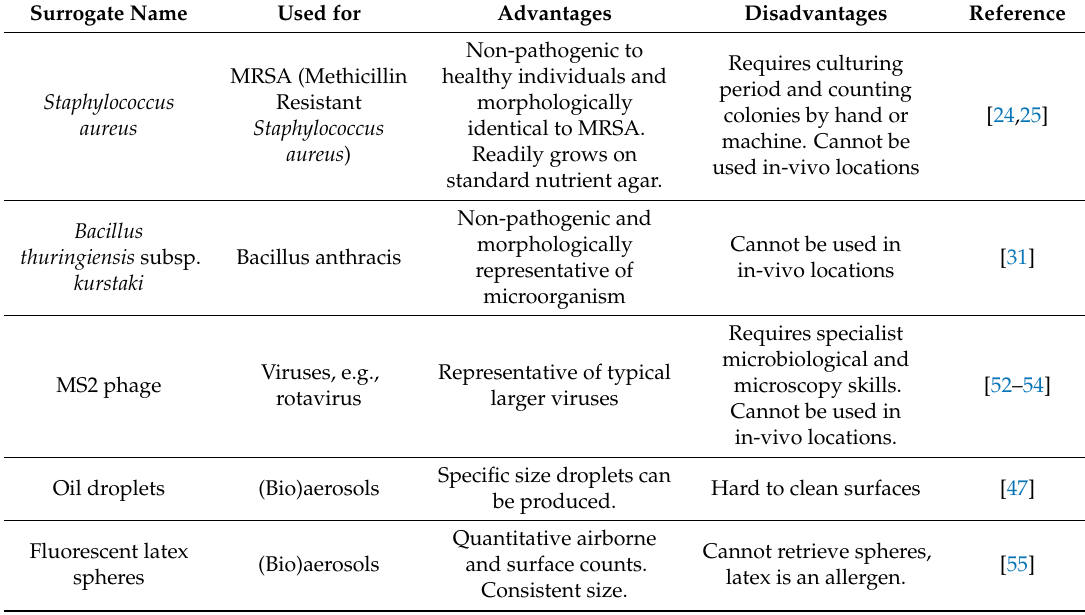
Table 1. Commonly-used tracer and surrogate techniques in indoor air experimental